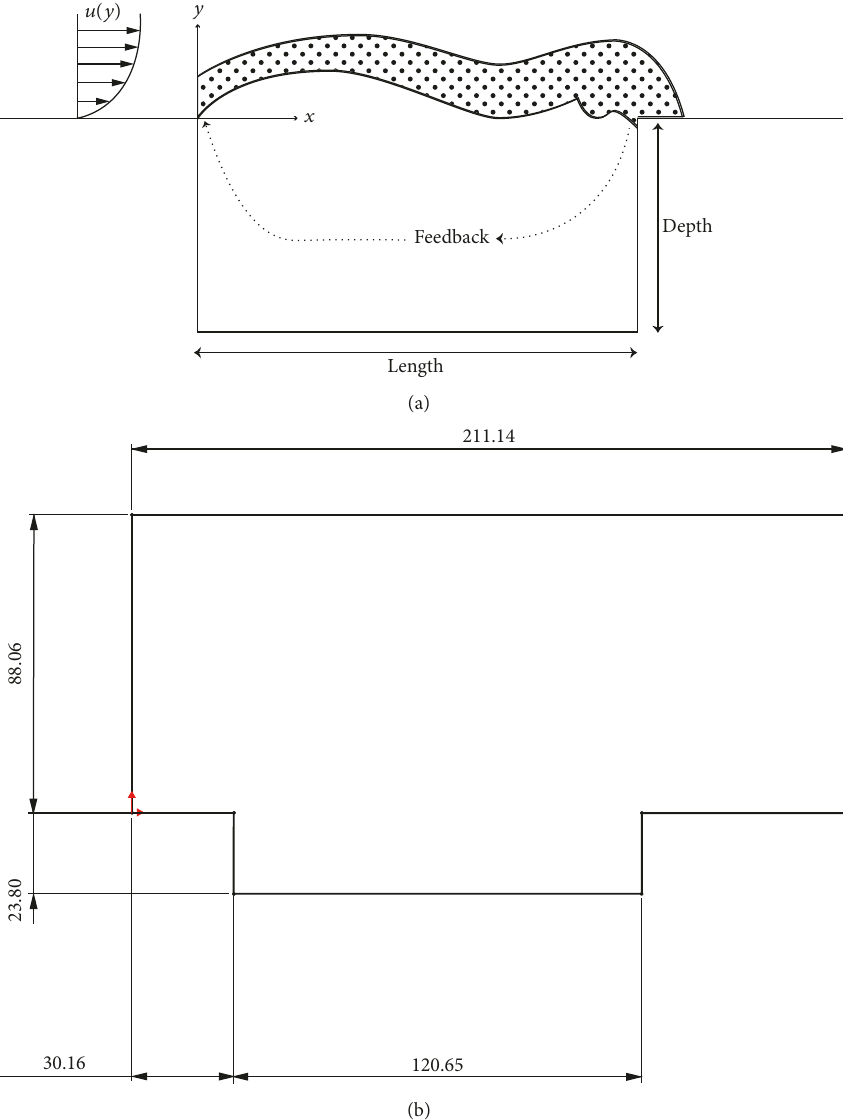
Figure 1: (a) Schematic view of the cavity. (b) Dimensions of the numerical domain.